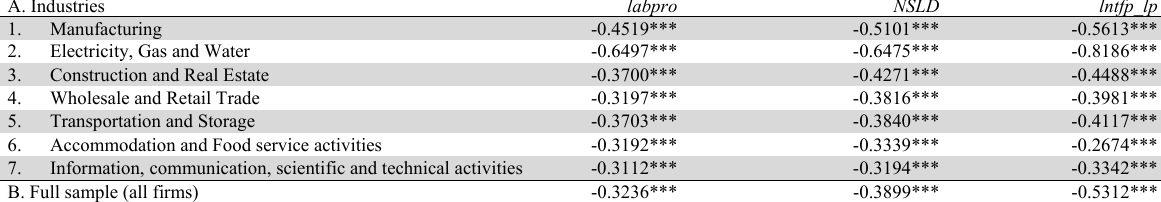
Correlations between FCIf and labor productivity, TFP